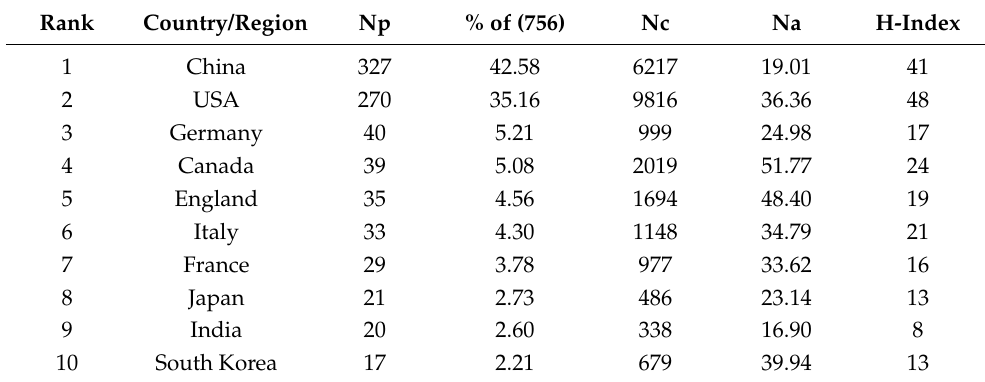
Table 1. Publications in the 10 most productive